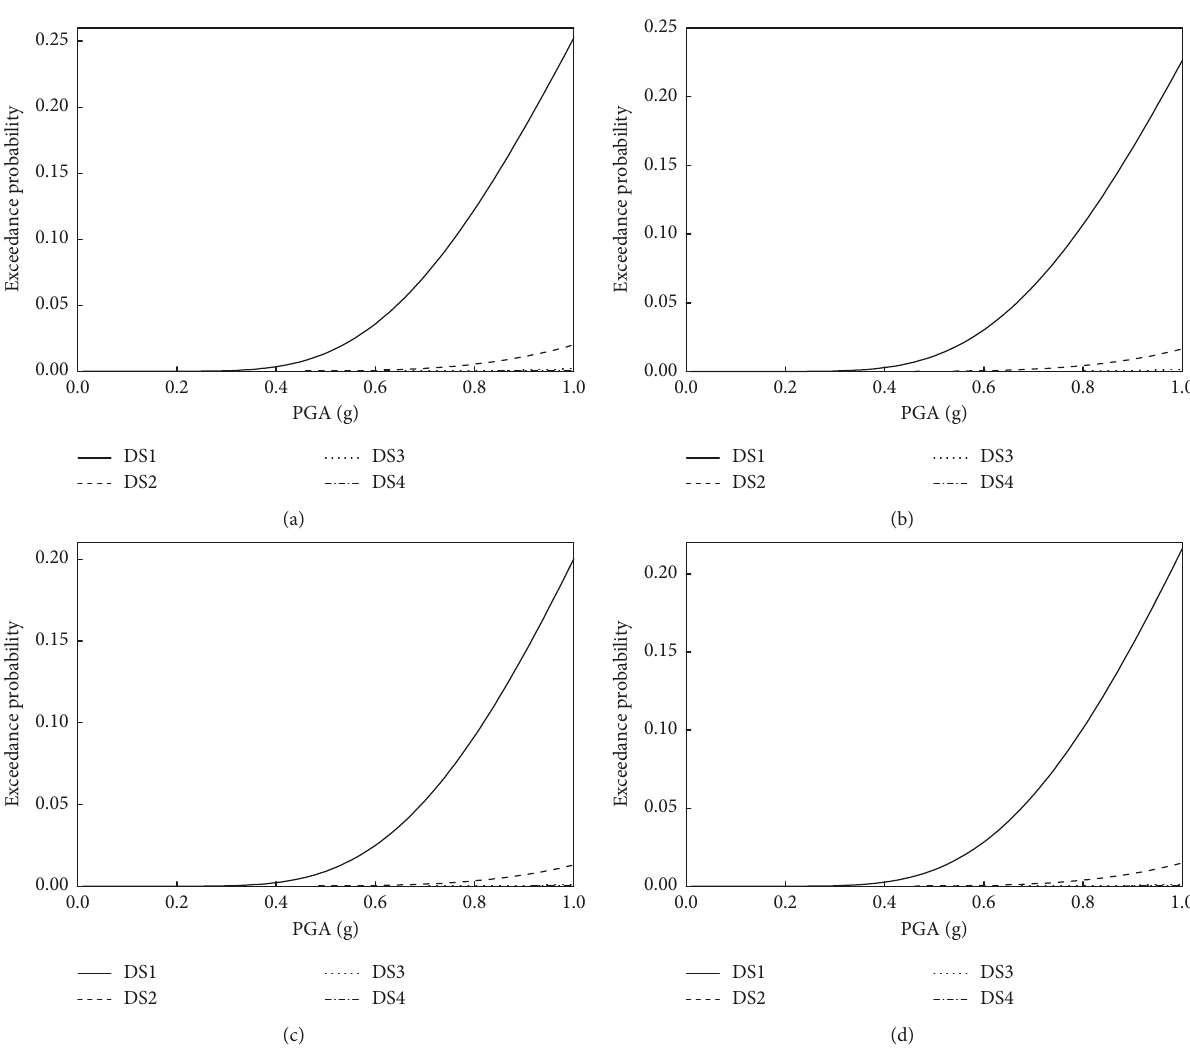
h . 0m, and h 1 (cid:31) 1 0 (cid:31) 0.001, K (cid:31) 100kN/m, 1 and C 0.001m 0kN s/m. (b) V d (cid:31) (cid:31) · 10kN − (cid:31) ·